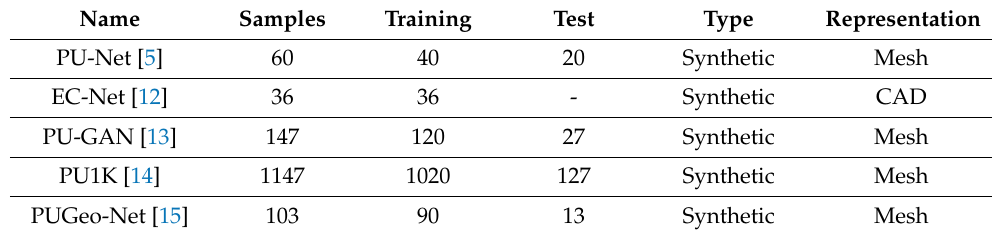
Table 2. Datasets constructed by researchers for